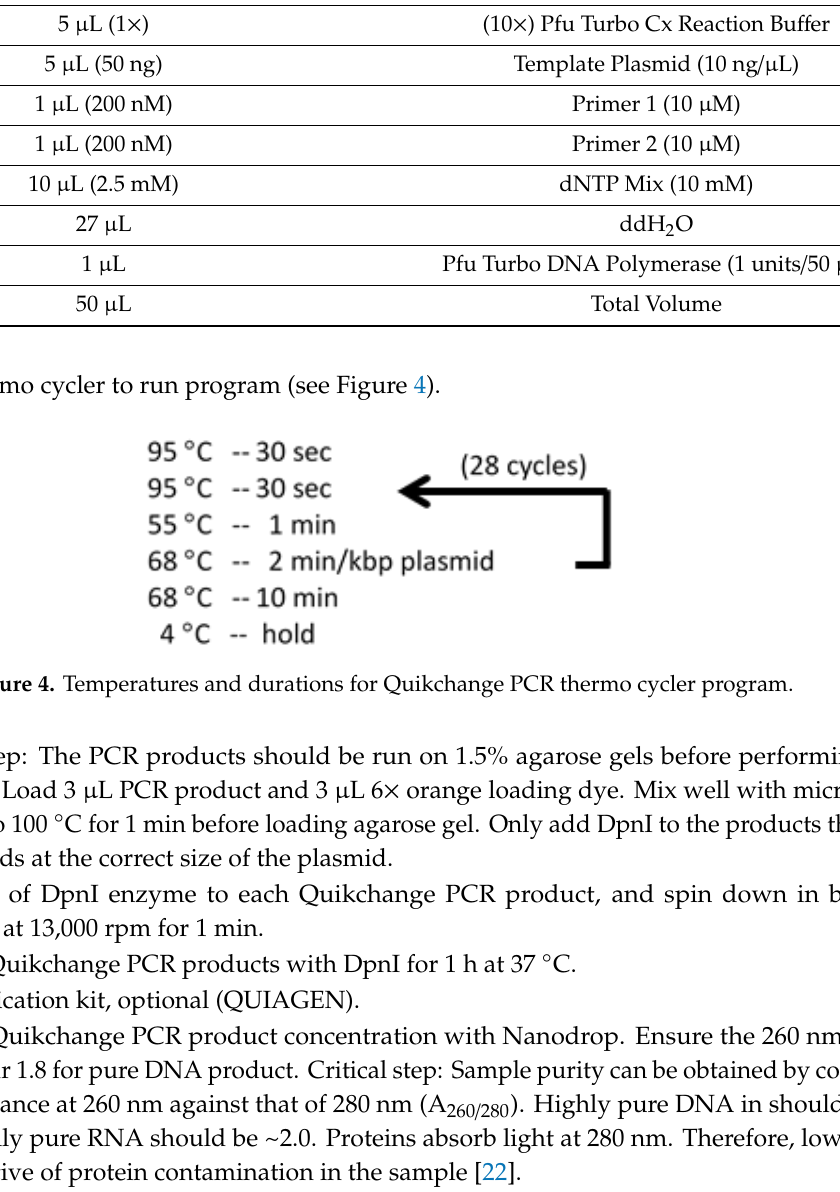
Table 1. Quikchange PCR reagents used in a generic reaction solution.